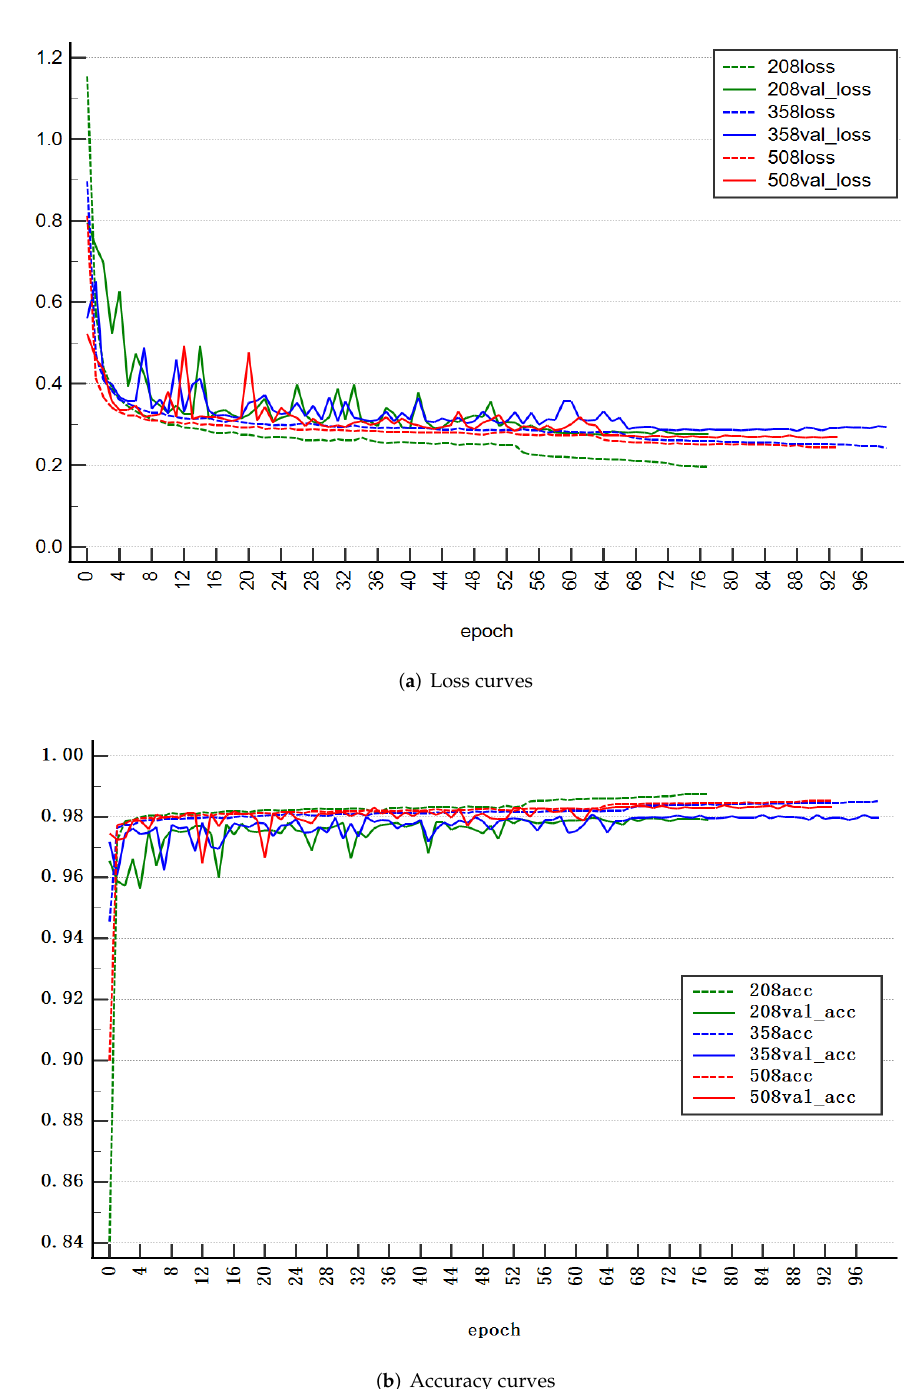
Figure 5. The loss curves and accuracy curves of the proposed model with different sizes of data set. The dotted line represents training and the solid line represents verification. The colors of green, blue and red represent data set sizes of 208, 358 and 508, respectively. The model with a data set size of 508 has lower loss and higher accuracy on the validation